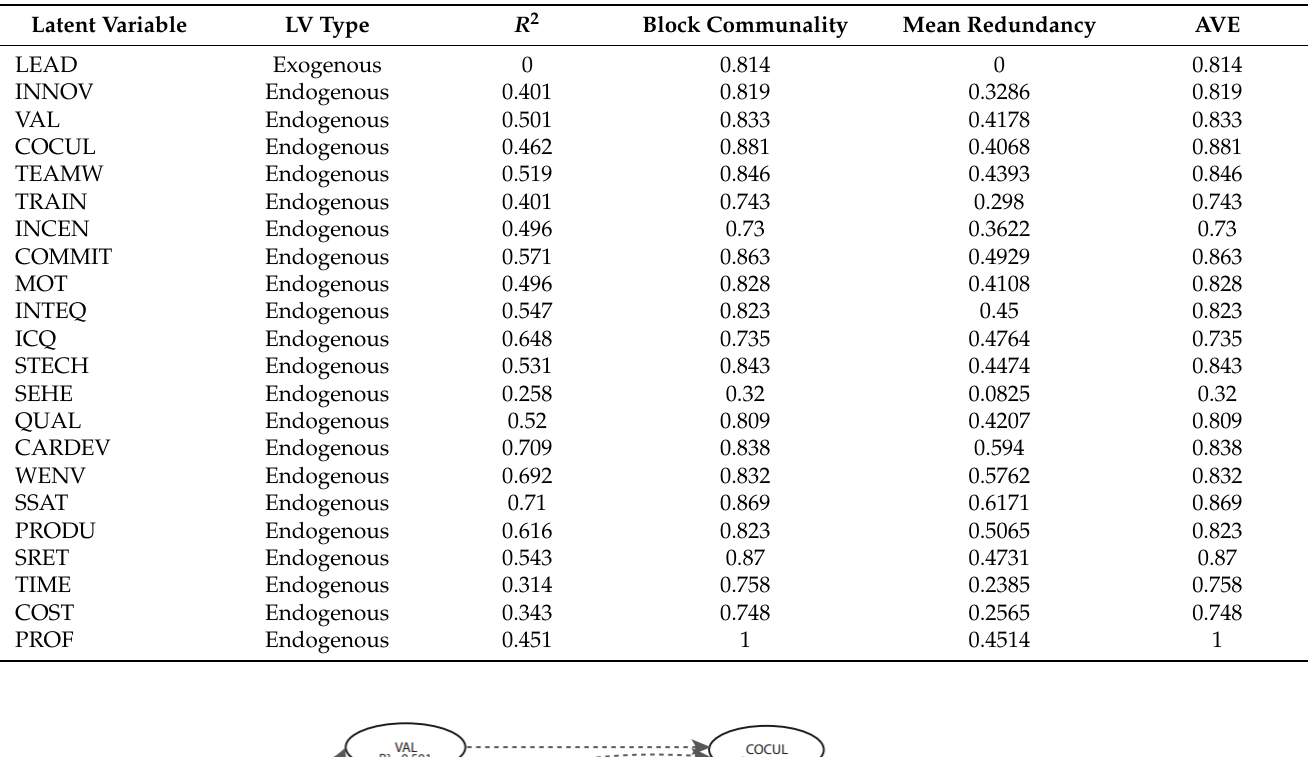
Table 6. Inner Model: Latent Variable, Type, R 2 , Block Community, Mean Redundancy, and Average Variance Extracted (AVE).